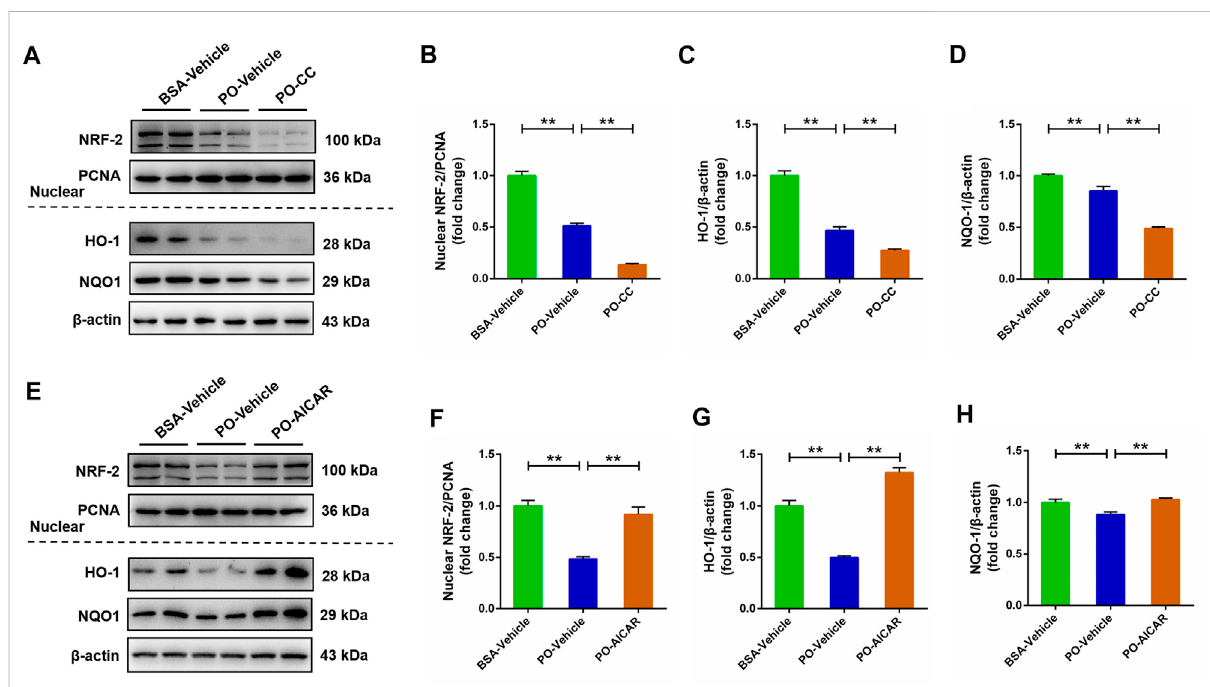
FIGURE 7 AMPK regulates the NRF-2 signaling pathways in PO-induced oxidative stress of hepatocytes. The primary chicken hepatocytes were pre- treated with/without 10 μ M AMPK inhibitor compound C for 1 h, and then stimulated with/without 0.75 mmol PO for another 24 h. (A) Immunoblot of nuclear factor erythroid 2-related factor 2 (NRF-2), heme oxygenase 1 (HO-1) and NAD (P) (H) quinone oxidoreductase 1 (NQO1); (B) Statistical analysis of nuclear NRF-2 protein level; (C) Statistical analysis of HO-1 protein level; (D) Statistical analysis of NQO1 protein level. The primary chickenhepatocyteswerepre-treatedwith/without1 mMAMPKactivatorAICARfor1h,andthenstimulatedwith/without0.75 mmolPOforanother 24 h. (E) ImmunoblotofnuclearNRF-2,HO-1andNQO1; (F) StatisticalanalysisofnuclearNRF-2proteinlevel; (G) StatisticalanalysisofHO-1protein level; (H) Statistical analysis of NQO1 protein level. Values represent the means ± SE. * p < 0.05 and ** p < 0.01, signi fi cantly different between the indicated treatment